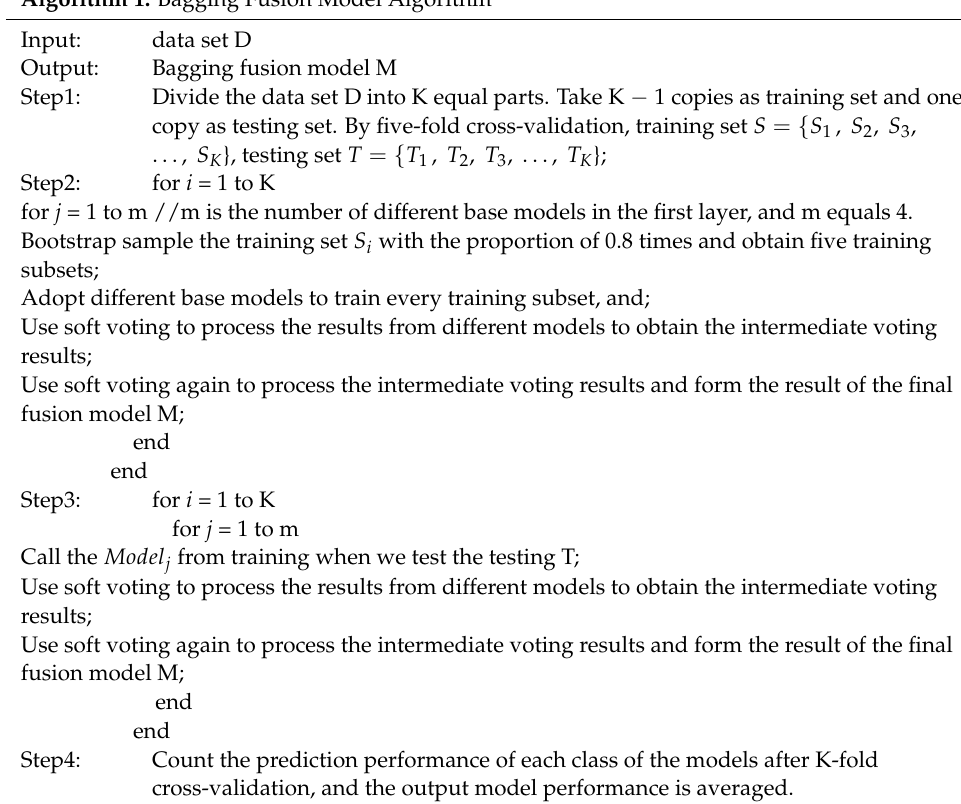
Algorithm 1. Bagging Fusion Model